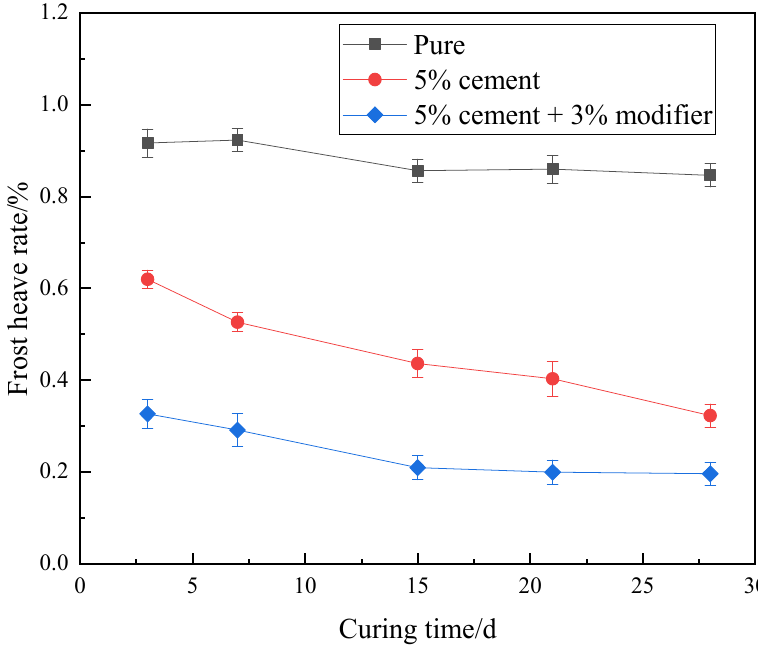
Figure 3. Influence curve of curing time on frost heave rate.